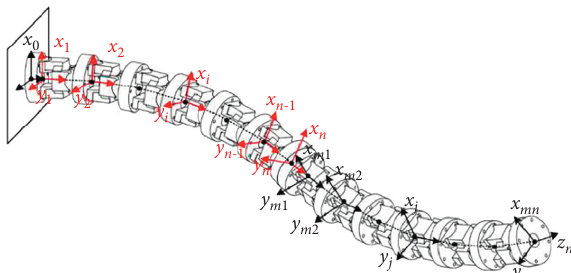
Figure 8: Coordinate system of the cable-driven hyper-redundant